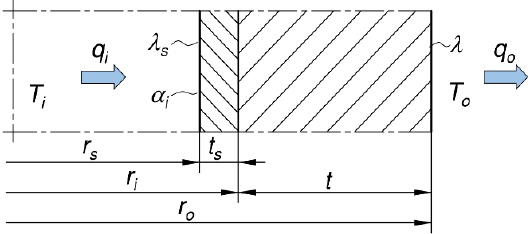
Figure 4. Diagram for determining the heat transfer coefficient.